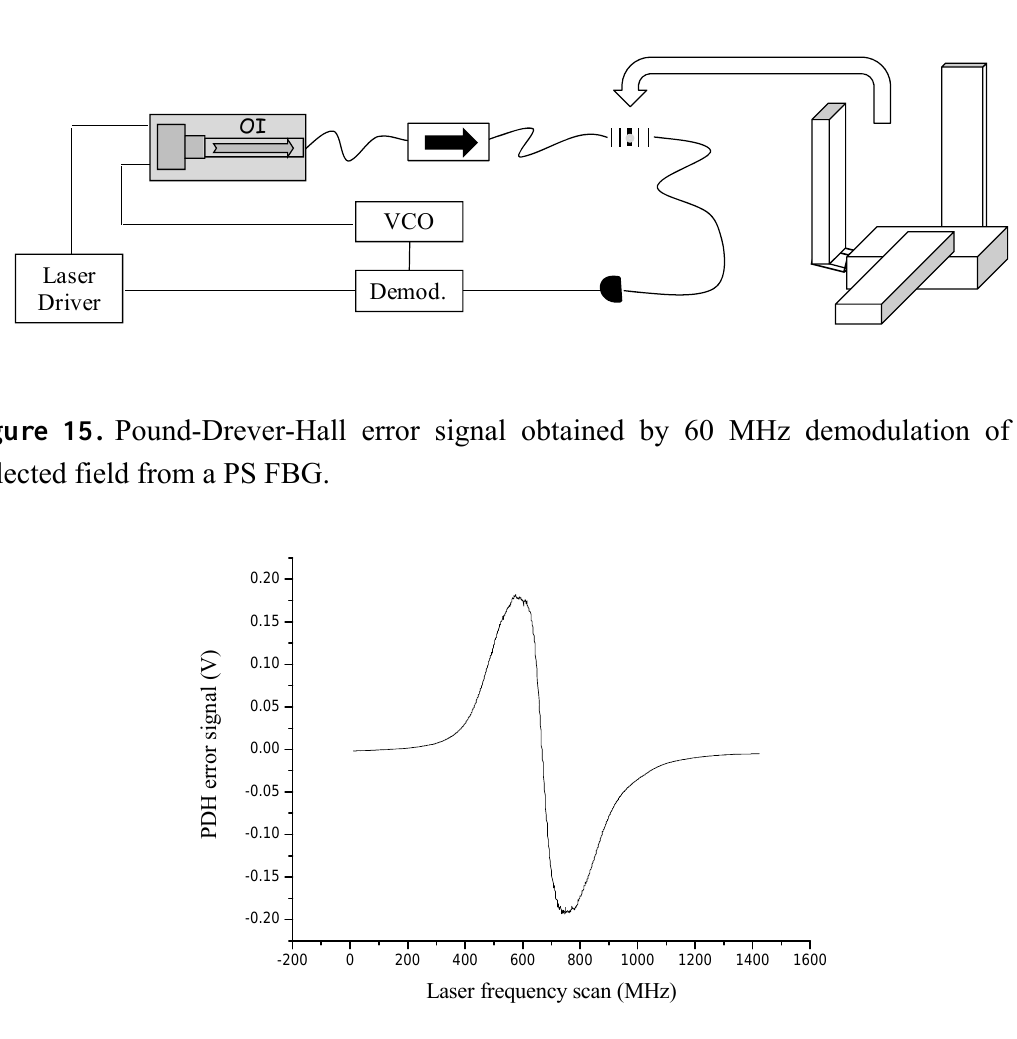
Figure 14. Schematic diagram of the accelerometer’s head. Stainless steel cantilevers are clamped together using aluminum plates. All cantilevers have the same dimensions and nominal resonant frequencies of about 1.5 kHz.